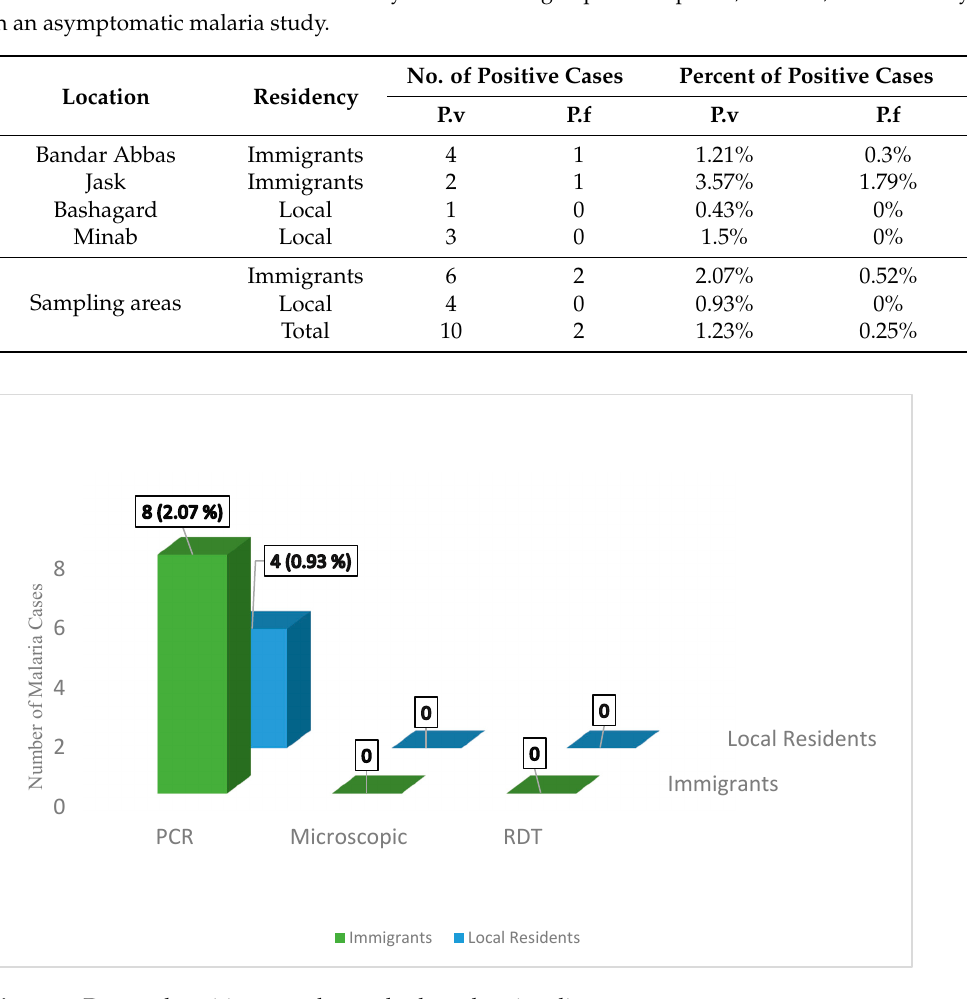
Figure 2. Detected positive cases by methods and nationality.